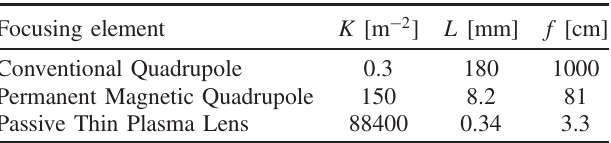
TABLE I. Comparison between focusing elements for a 10 GeV electron beam with Δ ψ ¼ 0 . 1 . Focusing